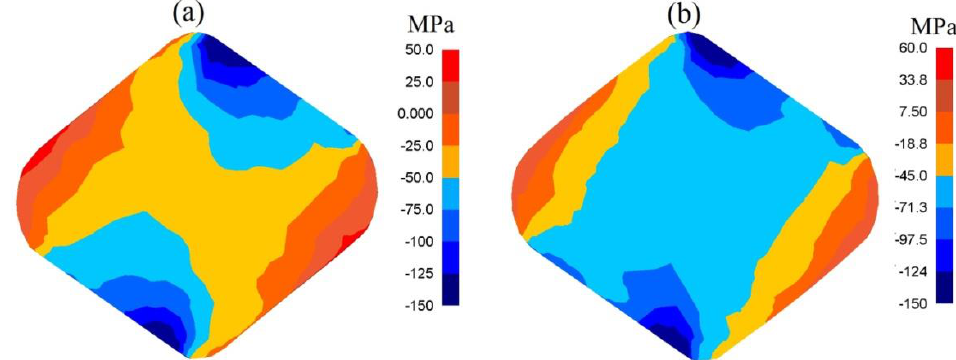
Figure 11. Distribution of mean stresses after the cogging process in anvils with skew working surfaces after the second pass (reduction ratio 0.70): ( a ) feed rate of 0.75; ( b ) feed rate of 1.20.